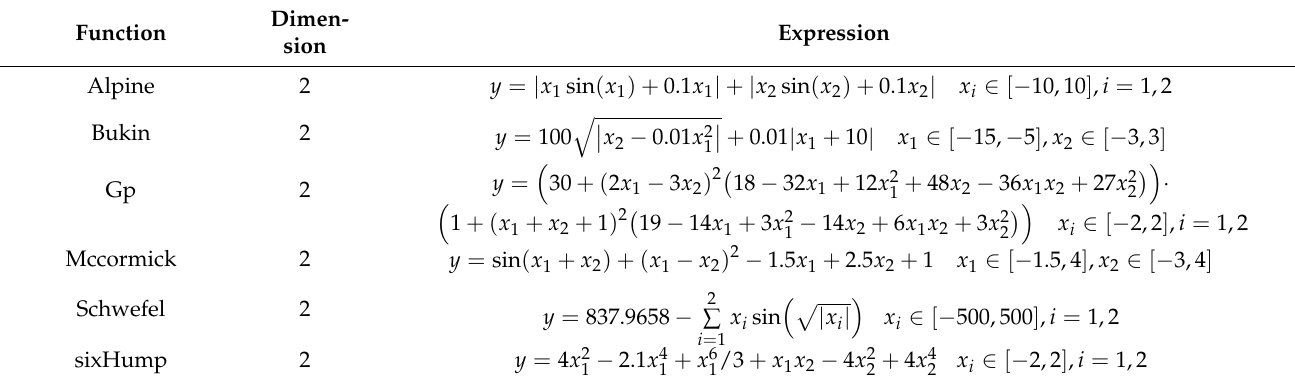
Table 4. Benchmark